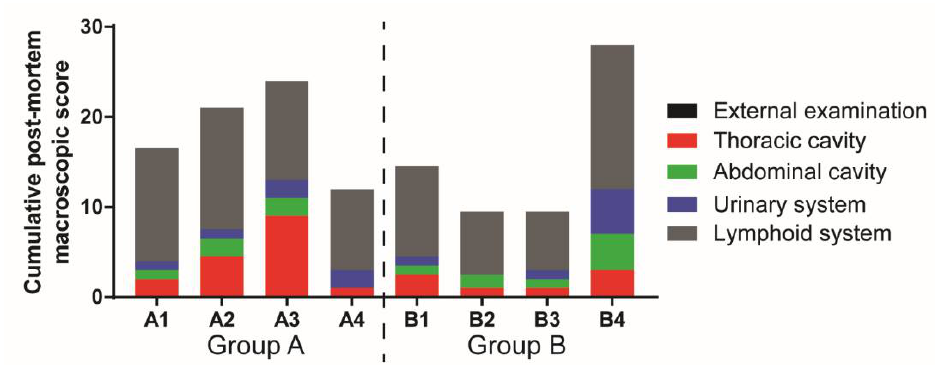
Figure 4. Post-mortem macroscopic lesion scoring. Lesions observed were scored and displayed as a cumulative score, observed in different organs of the pig. The external examination included general body condition and lesions in eyes, conjunctiva, nostrils, oral cavity, skin, subcutis, skeletal muscles and joints (black bar). Lesions in the thoracic cavity (red bar) include the presence of thoracic exudates, as well as lesions affecting the cardio-respiratory system. Lesions in the abdominal cavity (green bar) include the presence of ascites, along with the presence of lesions affecting the gastrointestinal system, including the stomach, intestines, liver and gallbladder. Lesions observed in the urinary system (kidneys and urinary bladder) are included in the blue bar. Finally, lesions depicted by the grey bar include pathology observed in lymphoid tissues: tonsils, thymus, spleen and various lymph nodes.